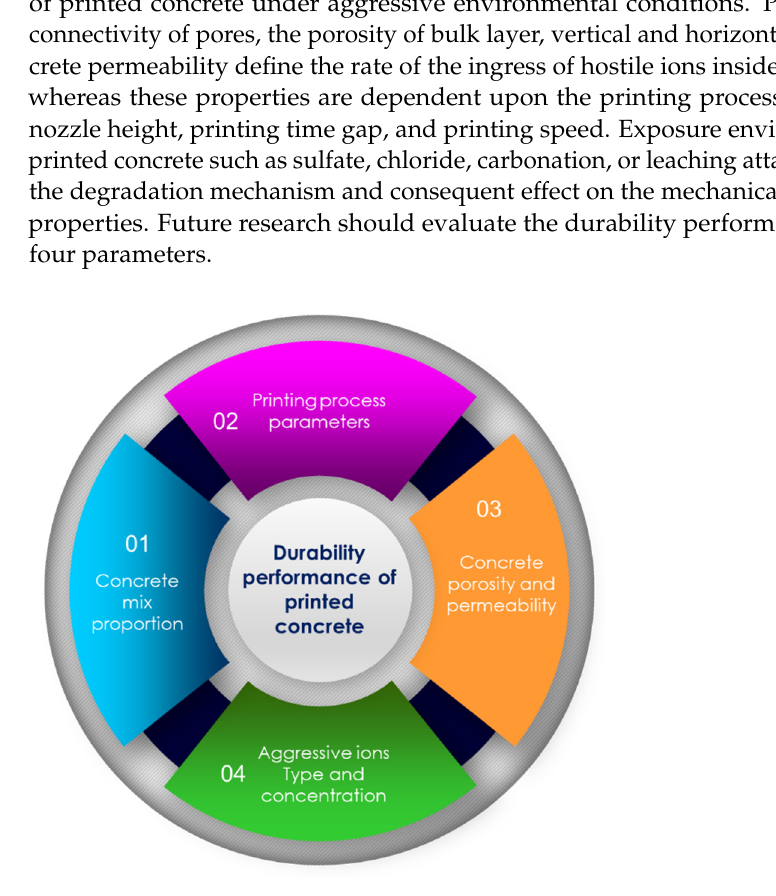
Figure 15. Parameters influencing the durability performance of 3D-printed concrete.